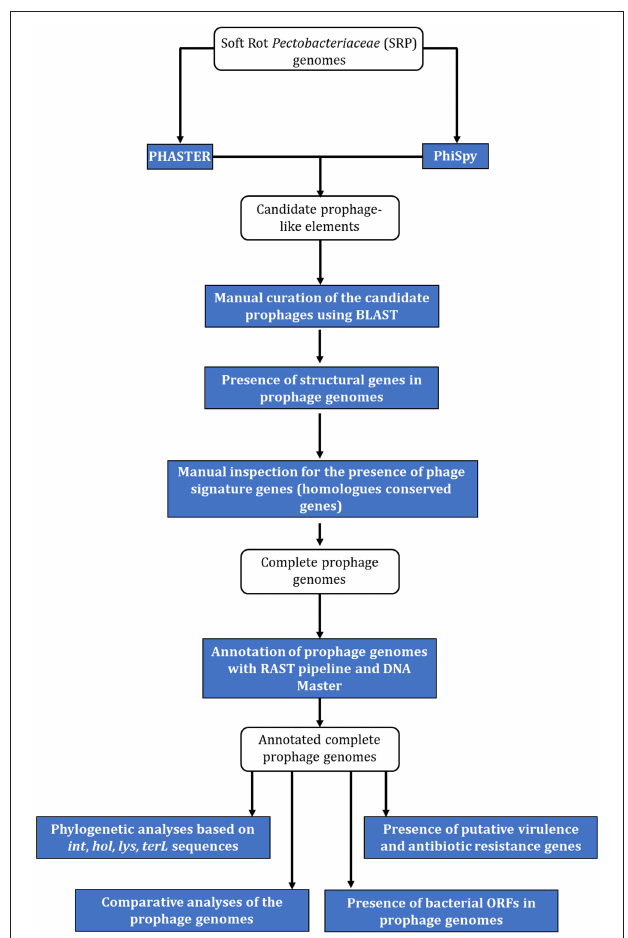
FIGURE 1 | The workflow for identification and characterization of SRP prophages. The blue rectangles represent the tools and methods used for identification of prophages’ sequences in bacterial genomes and the white rounded rectangles represent the (input) data used for the analyses.